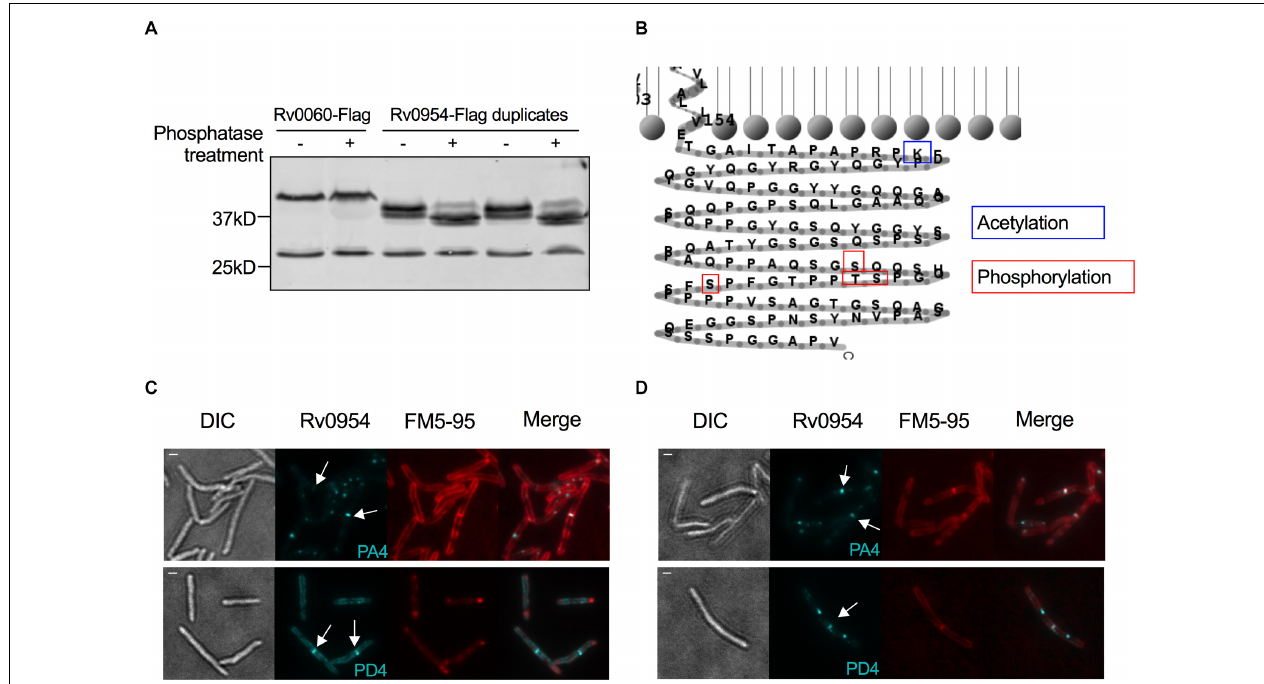
FIGURE 6 | Rv0954 is phosphorylated. (A) Detection of Rv0060-Flag (42 kD) and Rv0954-Flag (34 kD) in Mtb whole-cell protein lysates after treatment or not with alkaline phosphatase. The western blot was probed with an anti-Flag antibody. Data are representative of two independent experiments. (B) Schematic of the previously reported acetylation (Xie et al., 2015) and newly discovered phosphorylation sites in the C-terminus of Rv0954. (C,D) Representative microscopy images of phosphoablative (PA4) or phosphomimetic (PD4) Rv0954 mutants expressed in panel (C). WT Msm, or (D) Msm (cid:49) MSEMG_5518-perM msm :perM mtb . Msm cells were collected and stained with membrane dye FM5-95 before imaging. Arrows point to the mid-cell localization of Rv0954. Scale bar, 1 µ m.